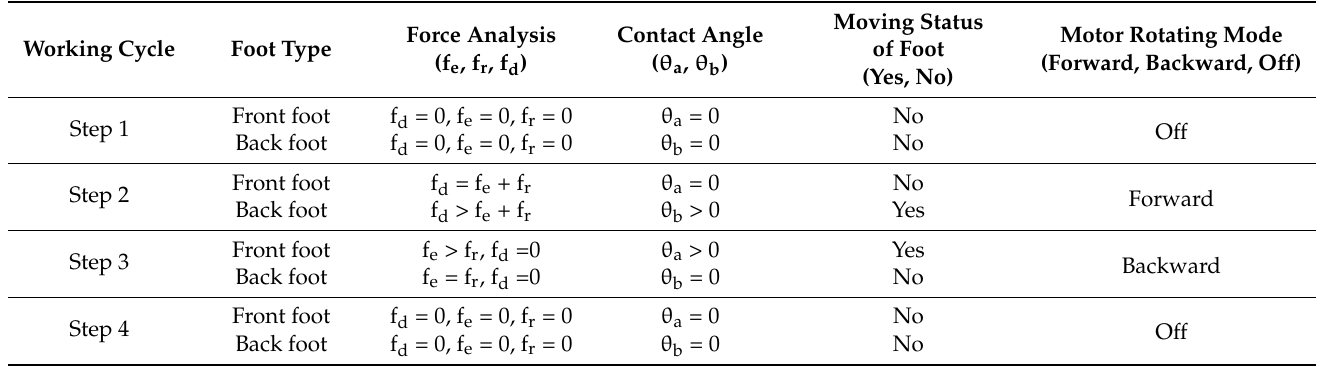
Table 4. Parameters of rubber sliding feet with forward motion in one working